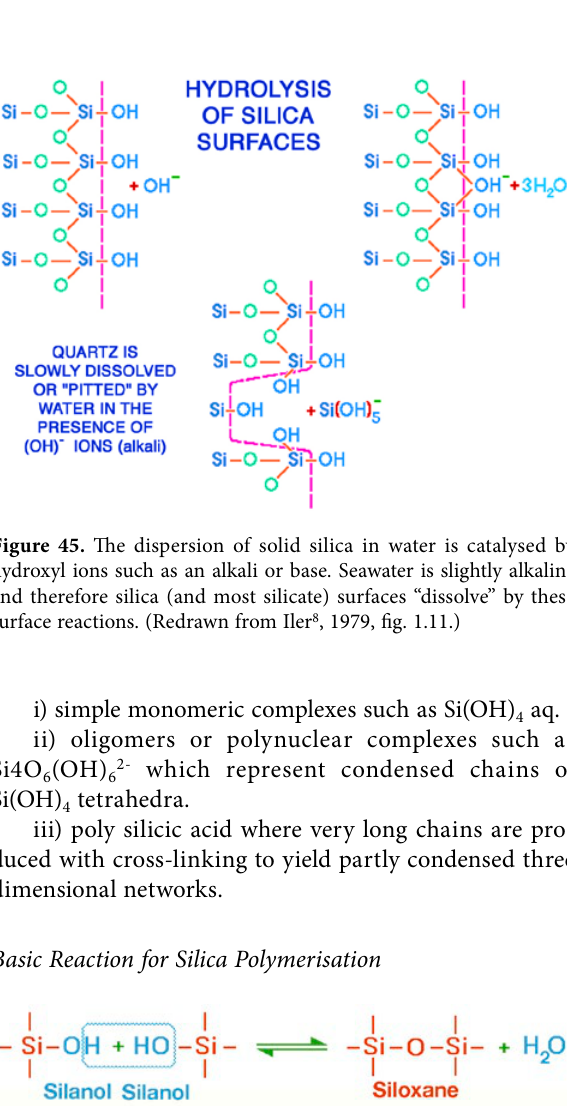
Figure 46. The basic reaction by which hydrated silica polymerises is divestment of water to form siloxane linkages.